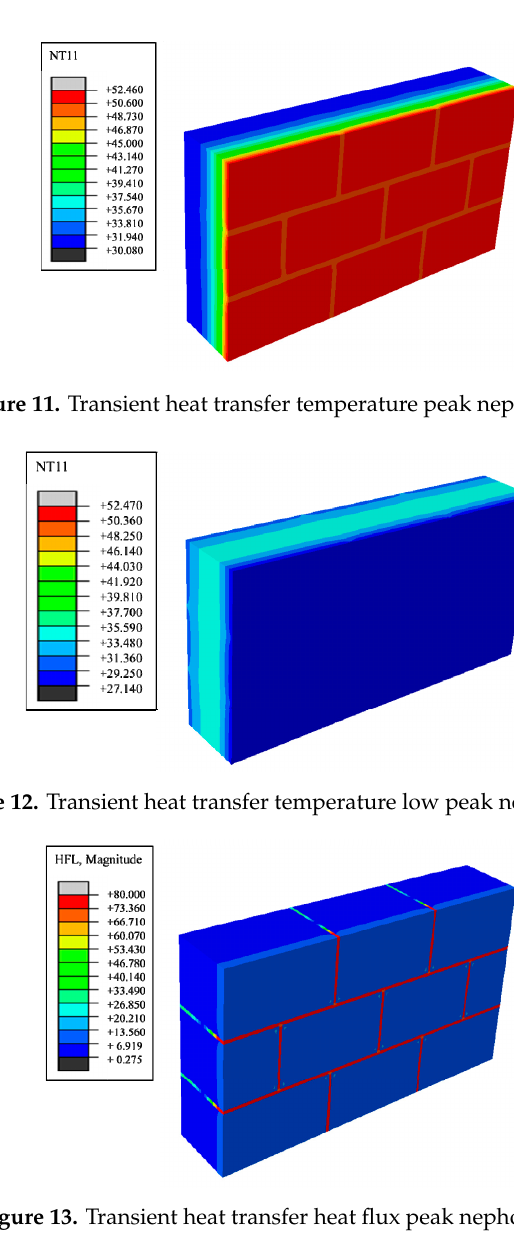
Figure 14. Transient heat transfer heat flux low peak nephogram. 0.0 5.0E4 1.0E5 1.5E5 2.0E5 2.5E5 3.0E5 0102030405060 normal add PCM T e m pe r a t u r e / ( ℃ ) Time/(s) Figure 15. Transient heat transfer temperature characteristic curve.